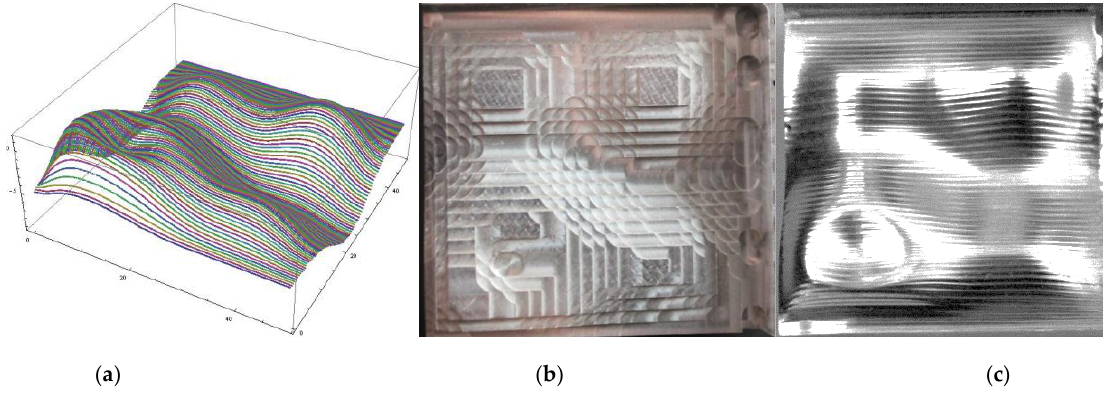
Figure 8. Processing toolpaths ( a ) of an ordered point cloud, ( b ) roughed part and ( c ) the finished part.